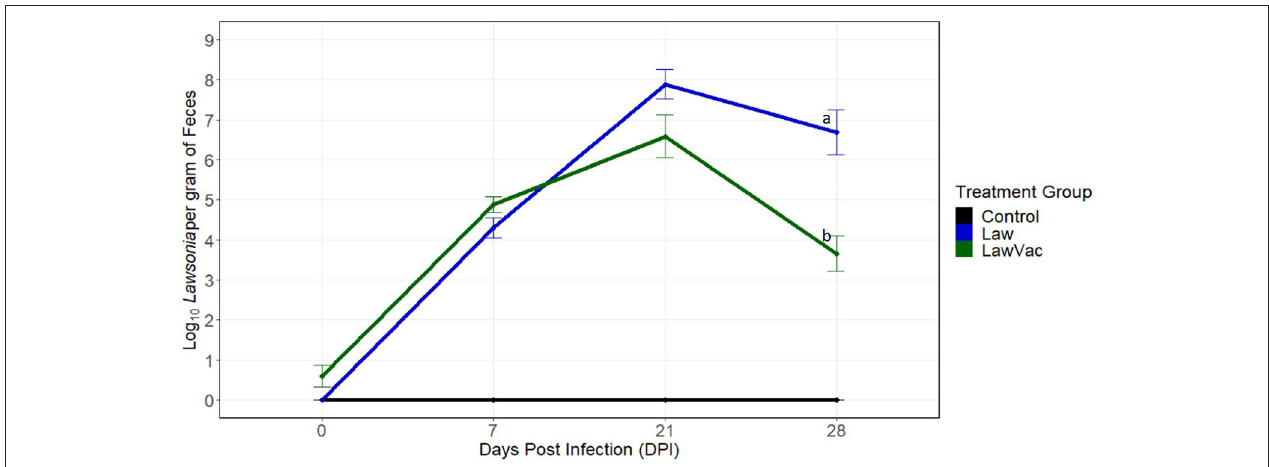
FIGURE 1 | Quantification of Lawsonia intracellularis shedding in fecal samples over time, measured by qPCR. Mean and standard error of the mean at 0 days post-infection ( n = 18 pigs per treatment group), 7 days post-infection ( n = 18 pigs per treatment group), 21 days post-infection ( n = 12 pigs per treatment group), and at 28 days post-infection ( n = 6 pigs per treatment group). Different letters indicate statistical significance [Wilcoxon rank-sum test ( p <